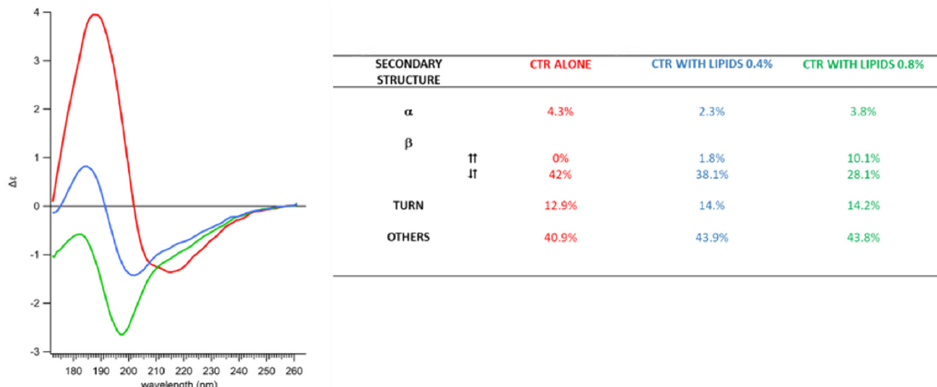
Figure 3. SRCD spectra of Hfq-CTR fibrils with EPE lipids. Hfq-CTR with liposome buffer (red); Hfq-CTR with 0.4 mM EPE (blue); Hfq-CTR with 0.8 mM EPE (green). Corresponding secondary